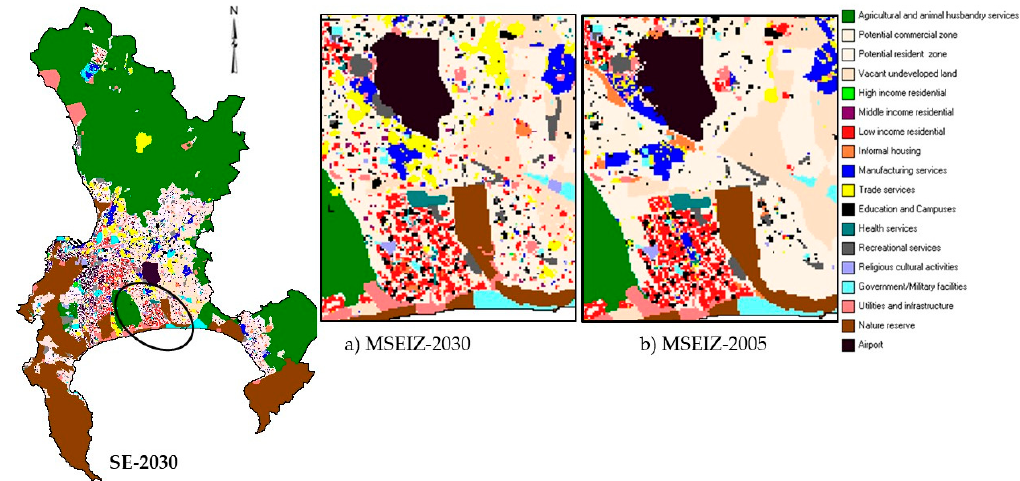
Figure 5. Metro South East Integration Zone; ( a ) MSEIZ-2030 under the SE scenario; ( b ) MSEIZ in 2005.